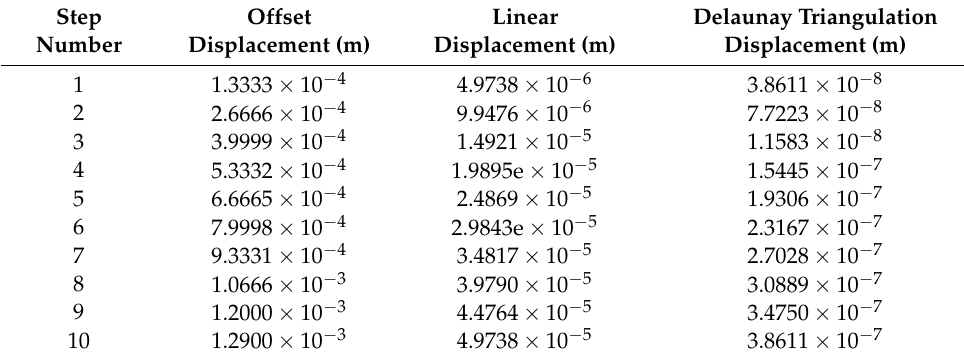
Table 2. Longitudinal displacement change table.